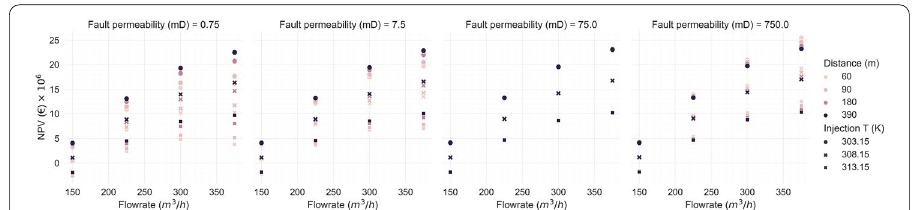
Fig. 10 Comparison of the generated NPV for the range of injection temperature, distance between the fault and the wells, flowrates and fault permeability